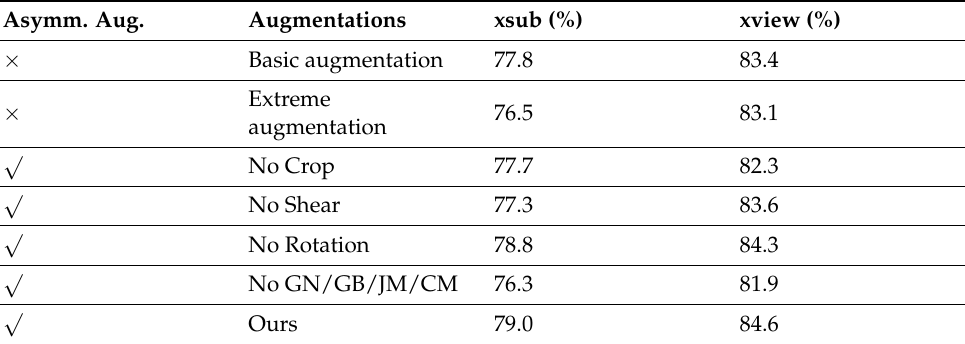
Table 2. Ablation experiments for data augmentation strategy on NTU-60 dataset. Asymm.